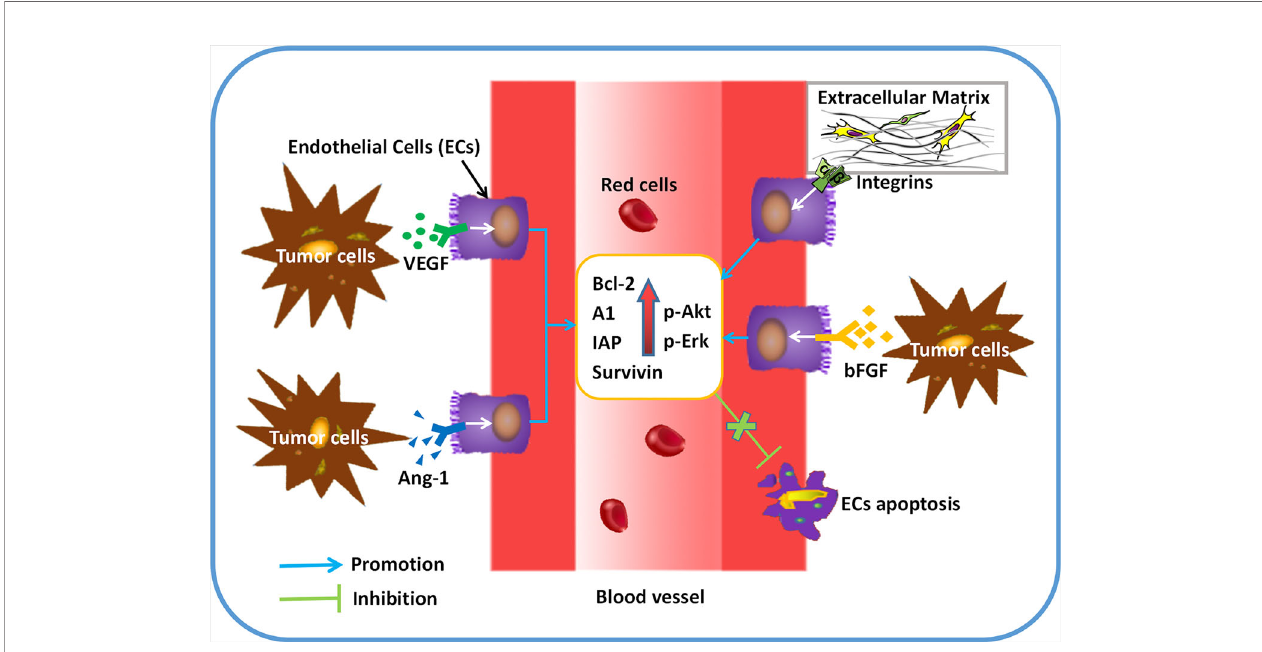
FIGURE 2 | ECs apoptosis can be regulated by pro-angiogenic factors in tumor angiogenesis. After secreting a variety of cytokines (VEGF, bFGF, Angiopoietin-1), tumor cells exerts the role of anti-apoptosis in ECs by binding to its receptors. Up-regulated expression of anti-apoptotic proteins (BCL-2, A1, IAP, etc) and protein kinases (Akt, Erk, etc) can be found in ECs, which results in more survival and less apoptosis in